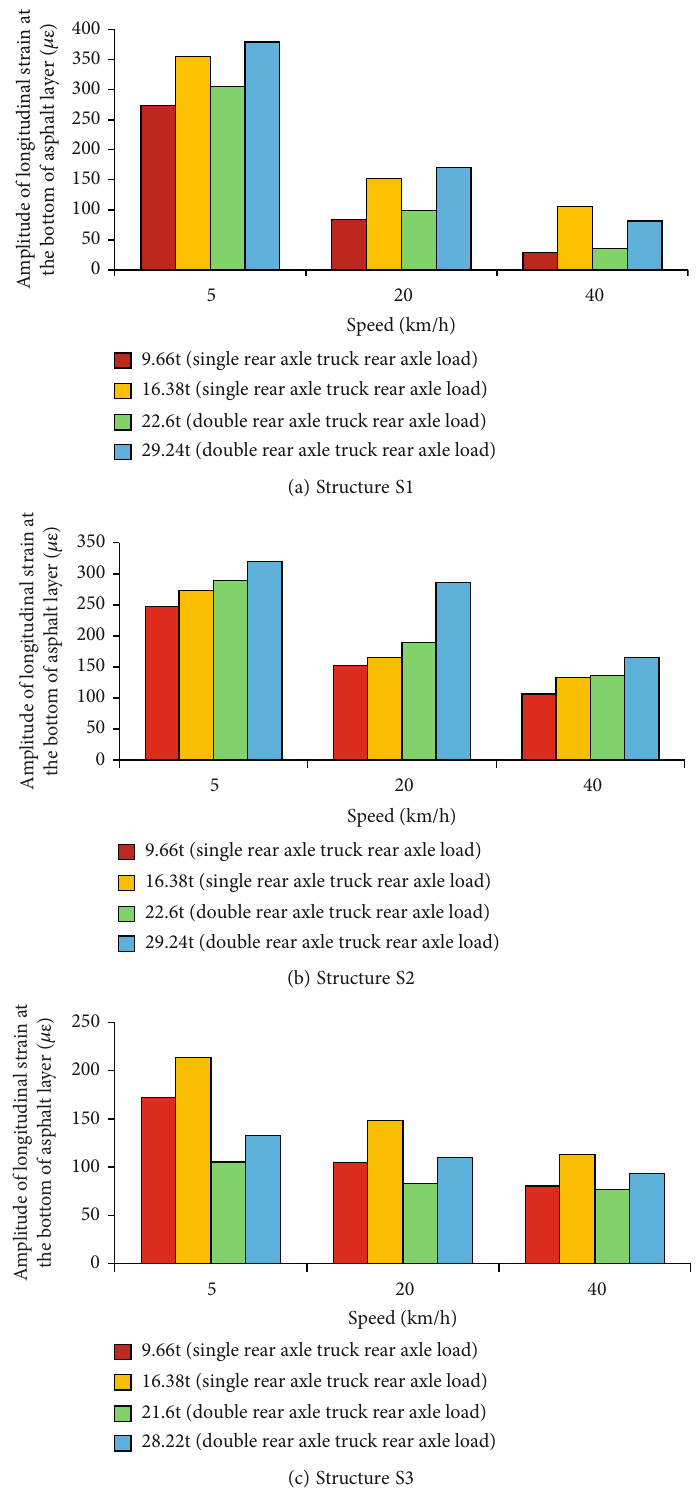
Figure 5: Relation between longitudinal strain amplitude at bottom of asphalt layer and axle